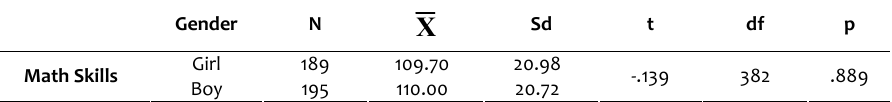
Table 8. Results of T-Test Analysis on Math Skills of the 5-Year-Old Preschoolers based on Gender